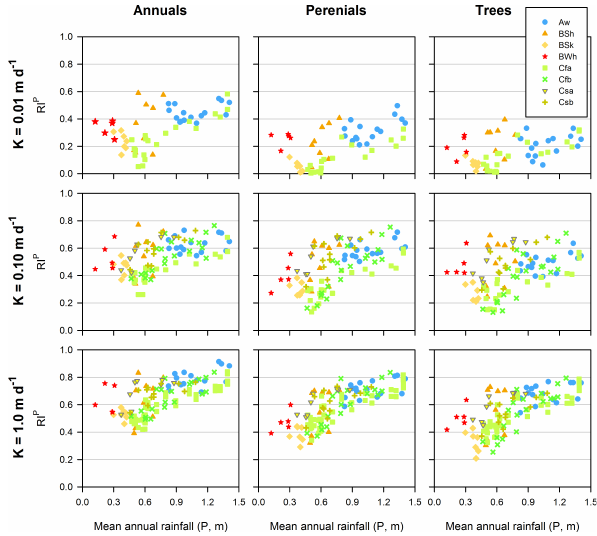
Fig. 4. Scatter plots of mean annual rainfall ( P ) and its relative importance (RI p ) in recharge estimation within considered climate types, under soil with selected hydraulic conductivities and vegeta- tion types.